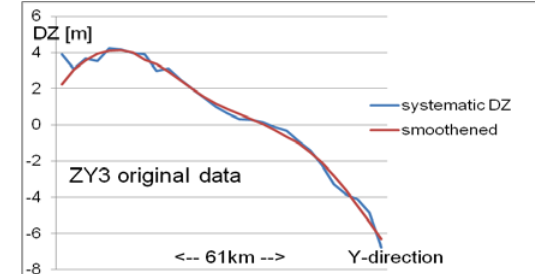
Figure 8. Systematic height errors in Y-direction, Saintes-